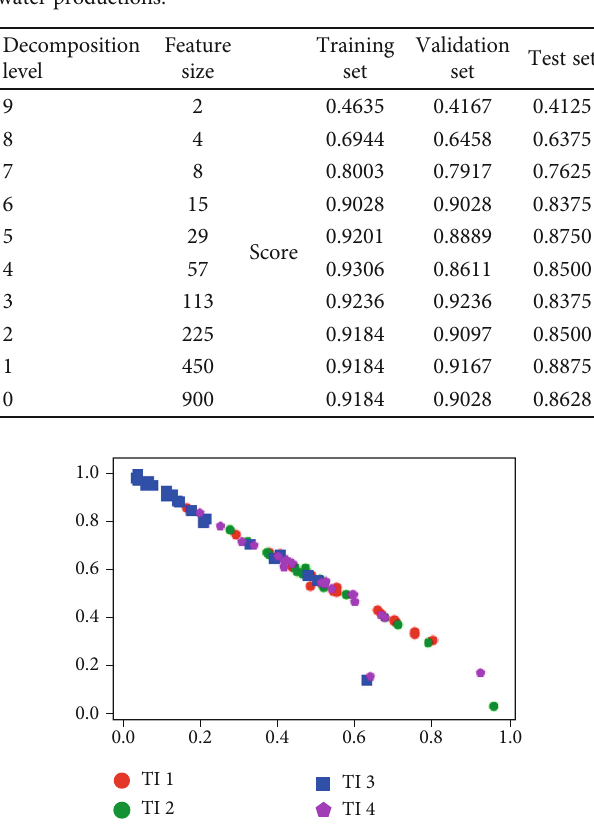
Figure 6: The distribution for the 80 test reservoir models in the 2D plane using the two features from the original 900 data by the